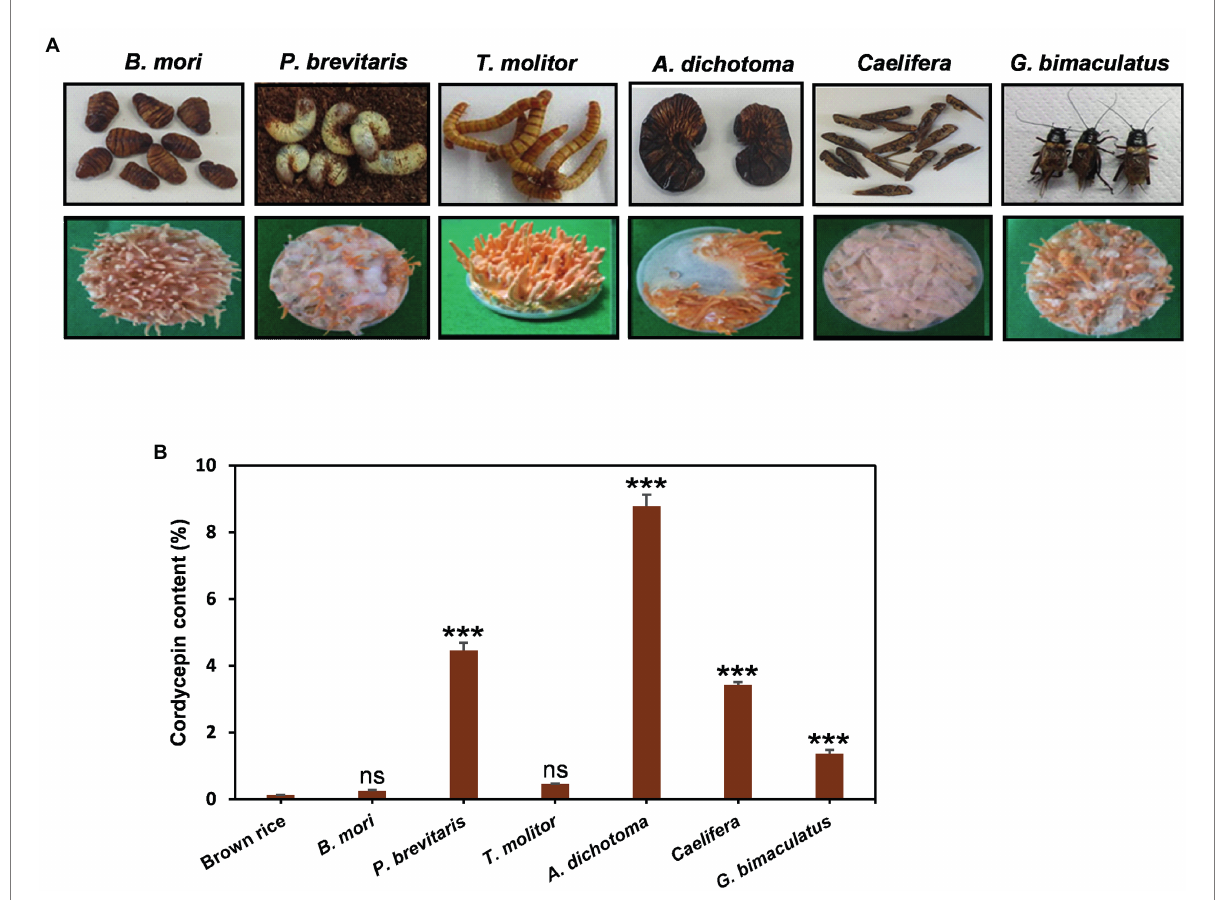
FIGURE 1 (A) Morphology and (B) , amounts of cordycepin in Cordyceps cultivated on six different edible insects. Cordyceps was grown for 35 days at 20 ° C and the amounts of cordycepin were quantified using HPLC analysis. *** p < 0.001 vs. Brown rice ( n = 3). *** p < 0.001 indicates significant differences, while ns. indicates no significant